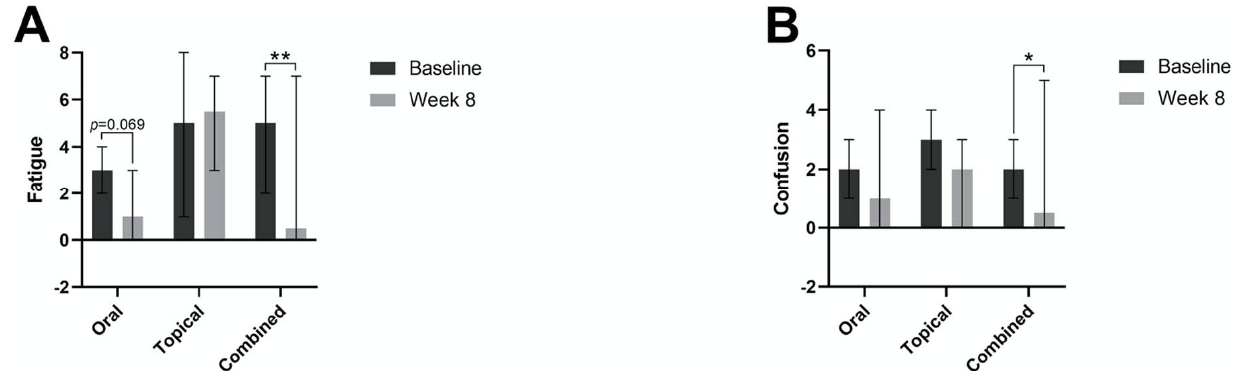
Figure 3. Median fatigue POMS scores ( A ) and median confusion POMS scores ( B ) with the oral, topical, and combined groups at the baseline and week 8. * p < 0.05; ** p < 0.01.